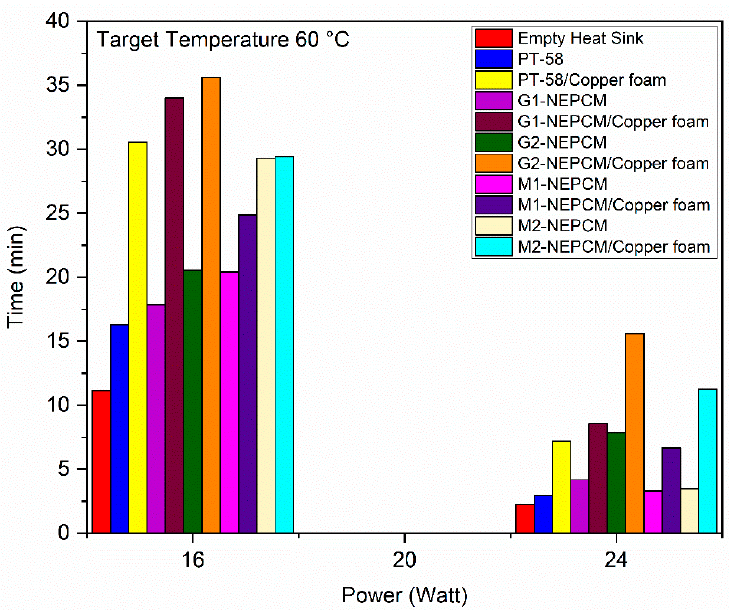
Figure 20. Time to attain target temperature of 60 ℃ for heat sink filled with PCM, NEPCM and NEPCM/copper foam composites.